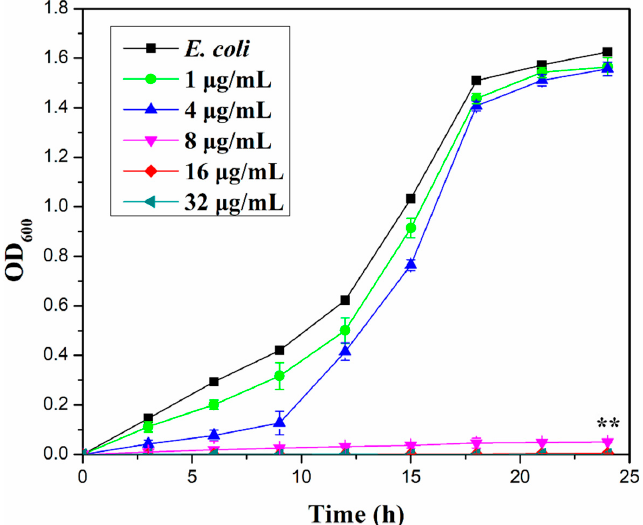
Figure 7. Growth curves of 100 mL E. coli suspension (10 4 CFU/mL) exposed to 0.1, 0.4, 0.8, 1.6, and 3.2 mg of Eu(OH) 3 /RGO after 24 h. Error bars represent the standard deviations (n = 3; n = numbers of experimental results); ** p < 0.01 indicates growth curve at 24 h was statistically significant compared with the control group.